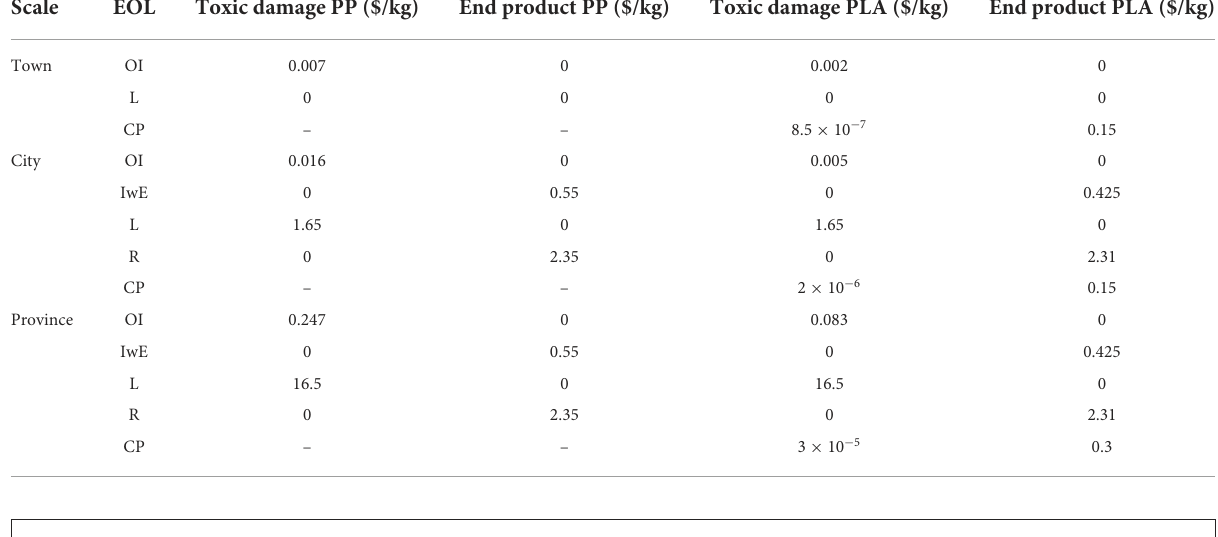
TABLE 6 TEA of externalities (OI, 100% Open Incineration; IwE, 100% Incineration with energy recovery; L, 100% Landfill; R, 100% Recycling; CP, 100% Composting).